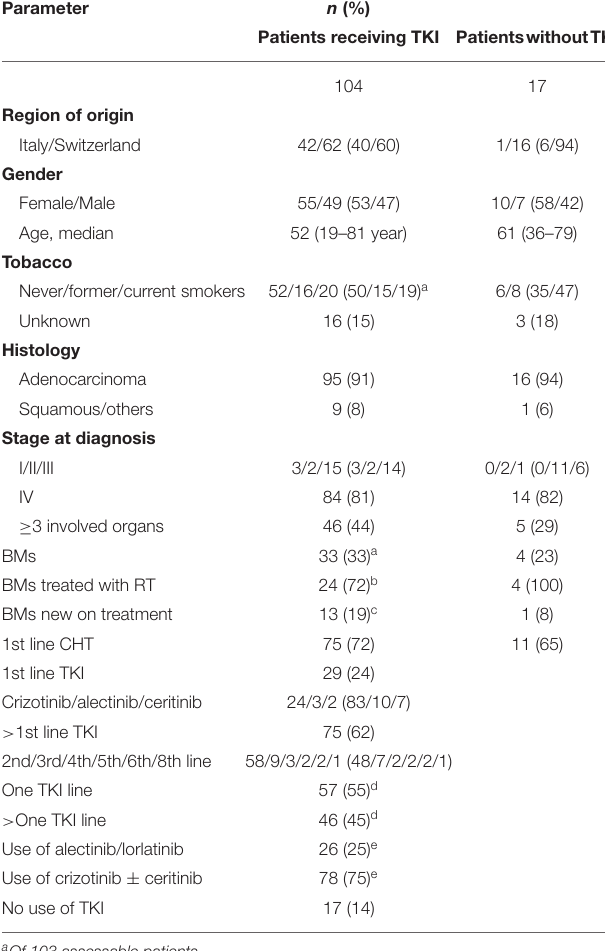
TABLE 1 | Characteristics of patients ( n =